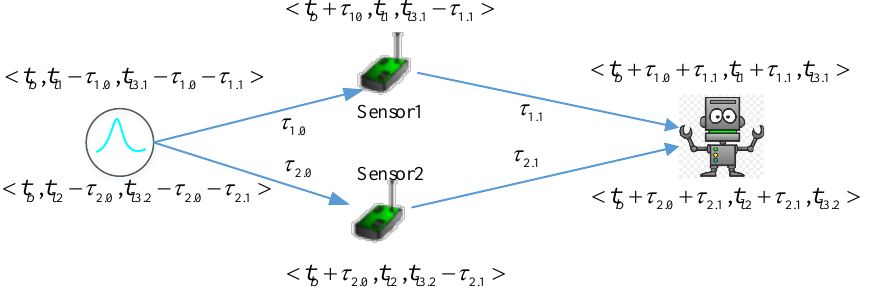
Figure 4. The observation timestamp of an event in different observers’ view.